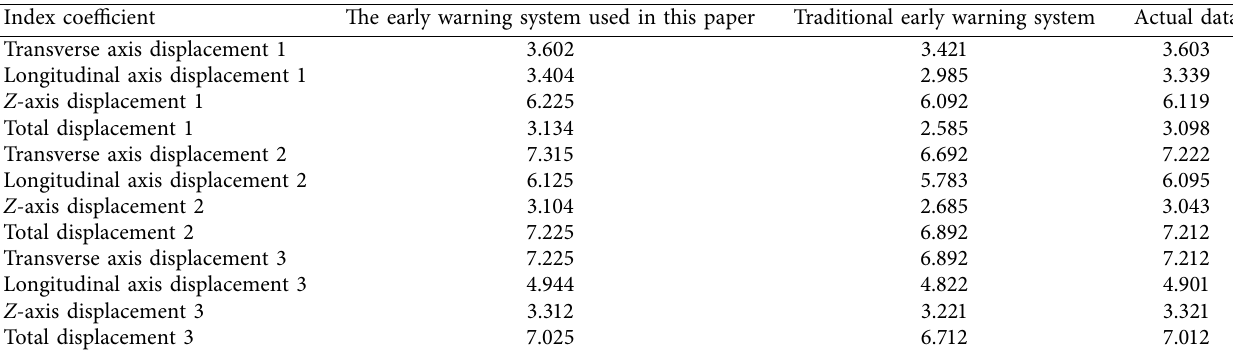
Table 6: Comparison of experimental data in area